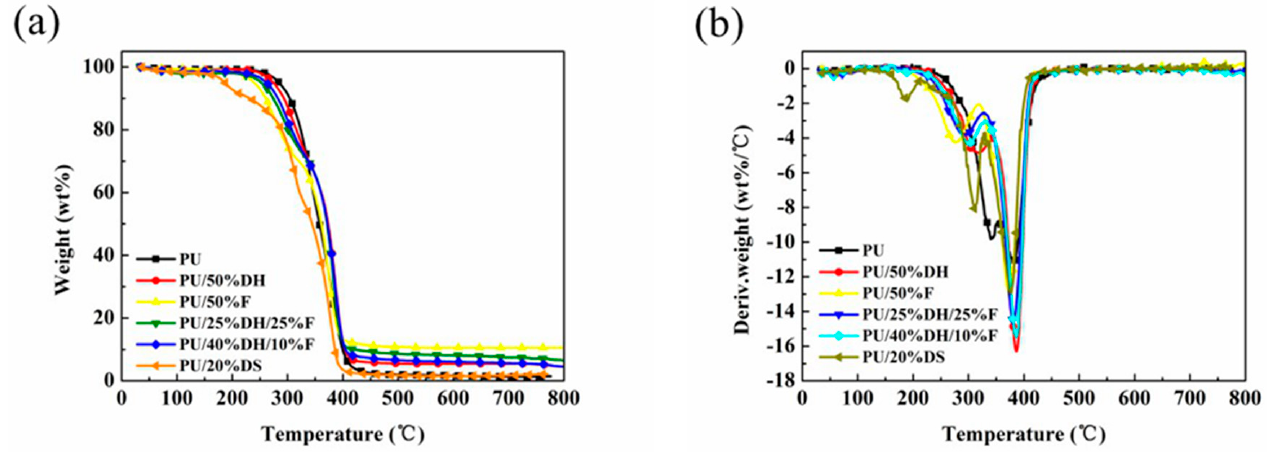
Figure 1. The FTIR spectra of PU-P after chain extension.